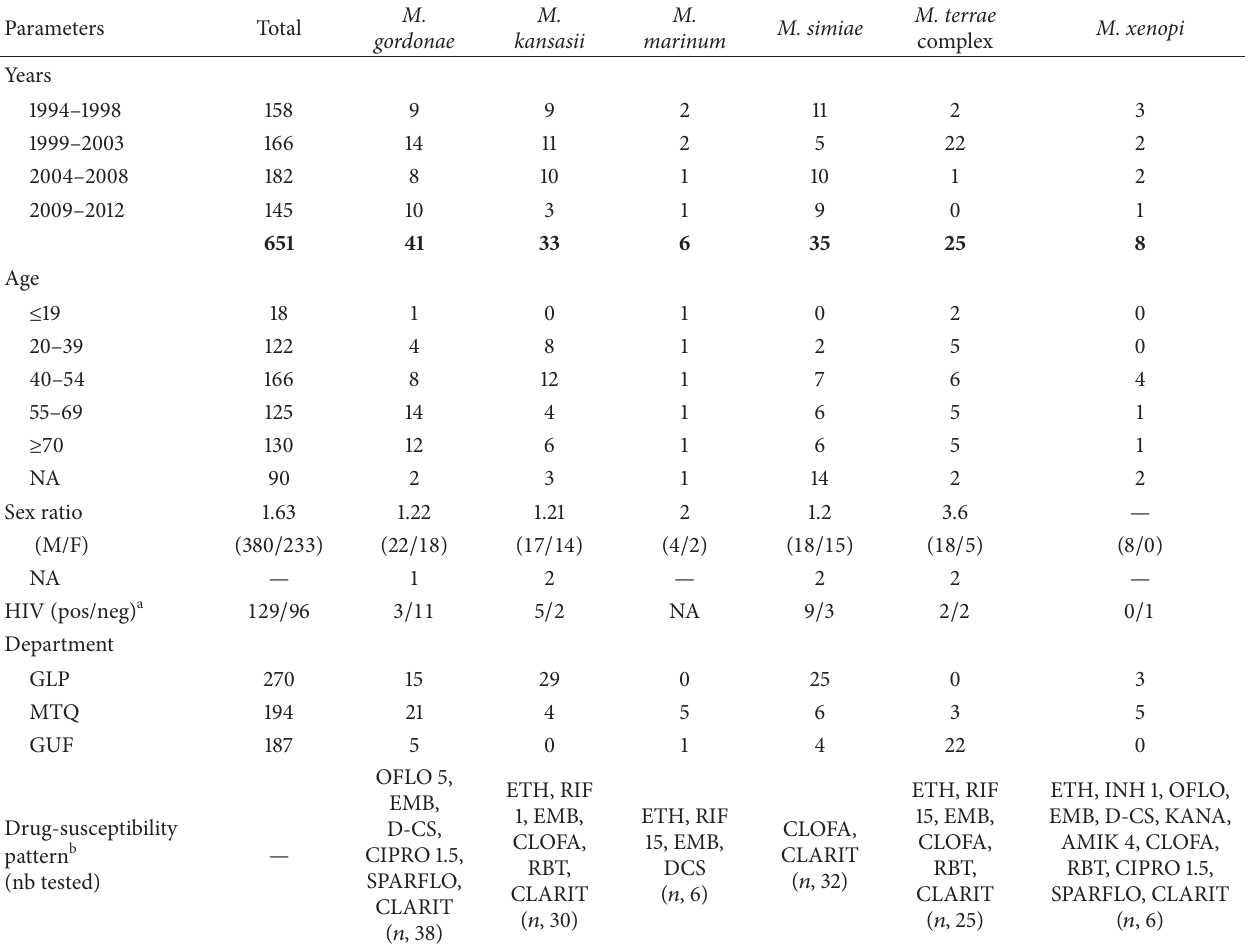
Table 2: Isolation patterns of regularly encountered